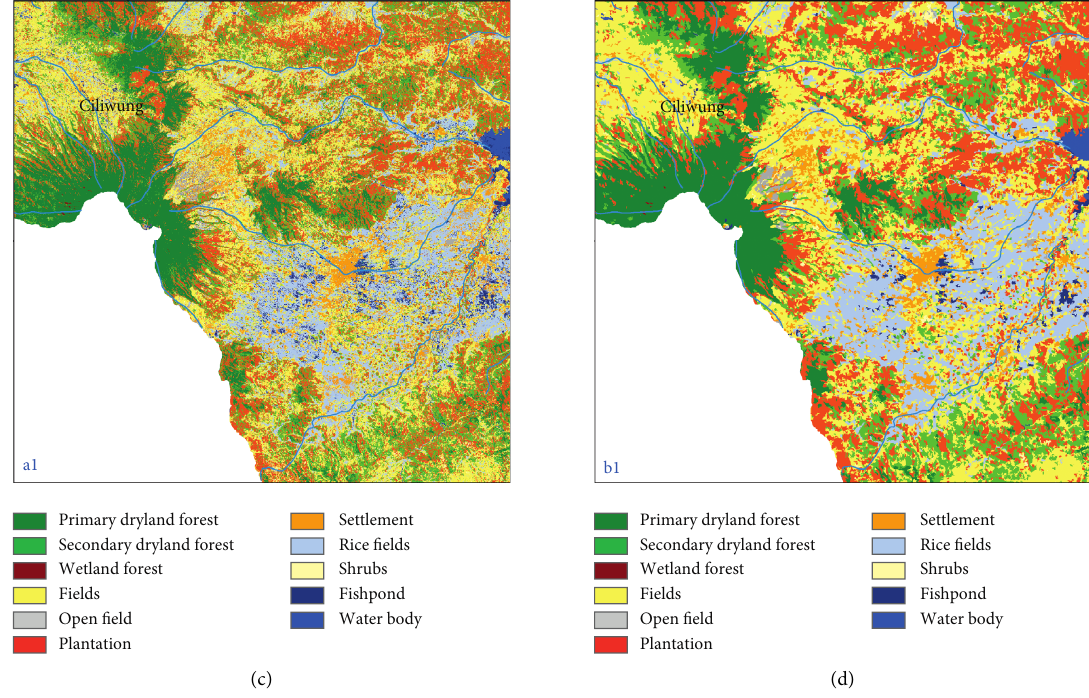
Figure 7: Result of the LULC classification based on the SVM classifier: (a, c) process stages without the MaSegFil approach; (b, d) process stages with the MaSegFil approach.